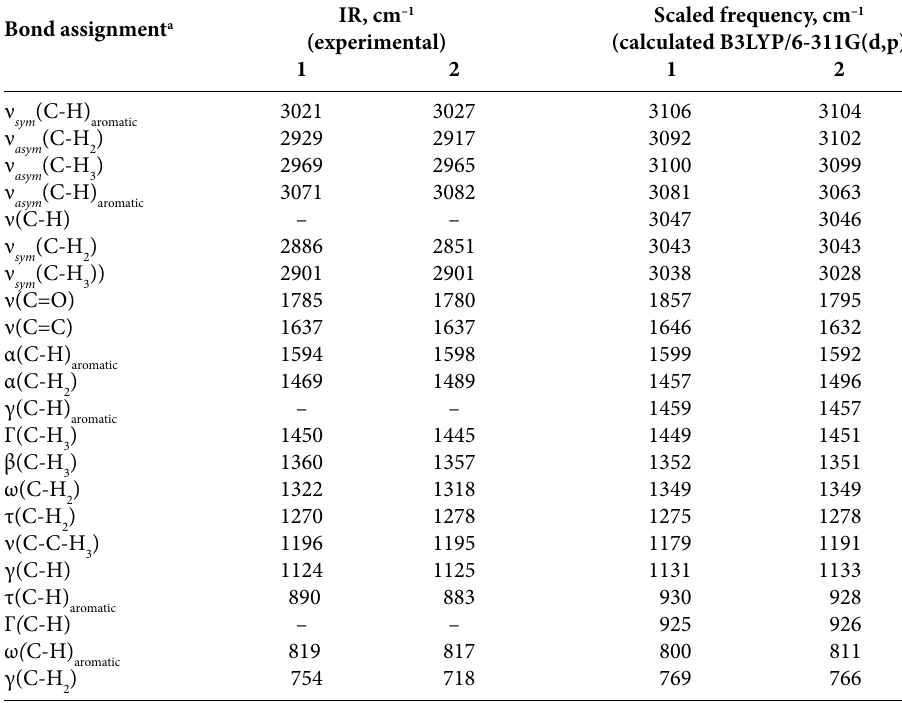
Table 4 . Comparison of the observed and calculated vibrational spectrum of the compounds. Bond assignment a